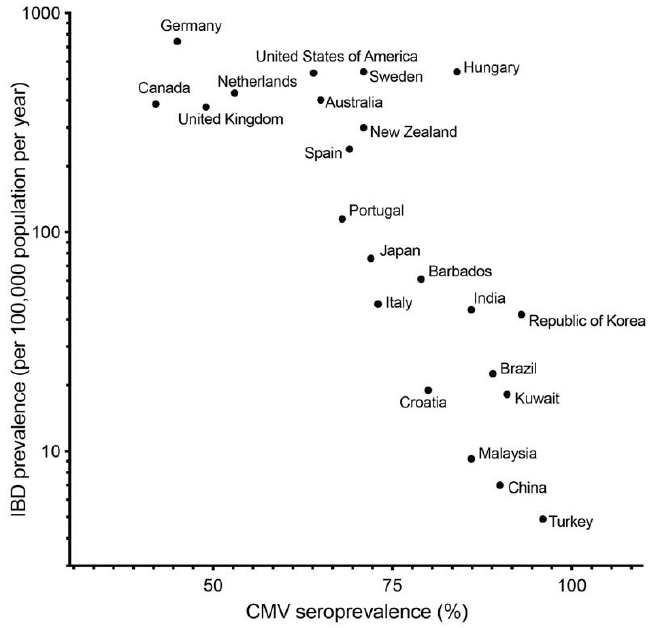
Figure 1. Relationship between seroprevalence of cytomegalovirus and prevalence of inflammatory bowel disease. bowel